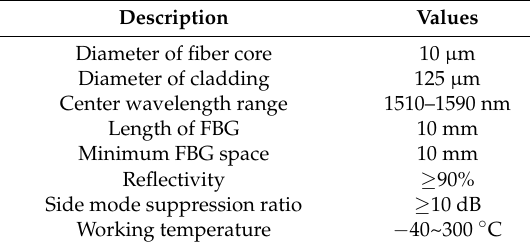
Table 1. Optical fiber and FBG parameters.